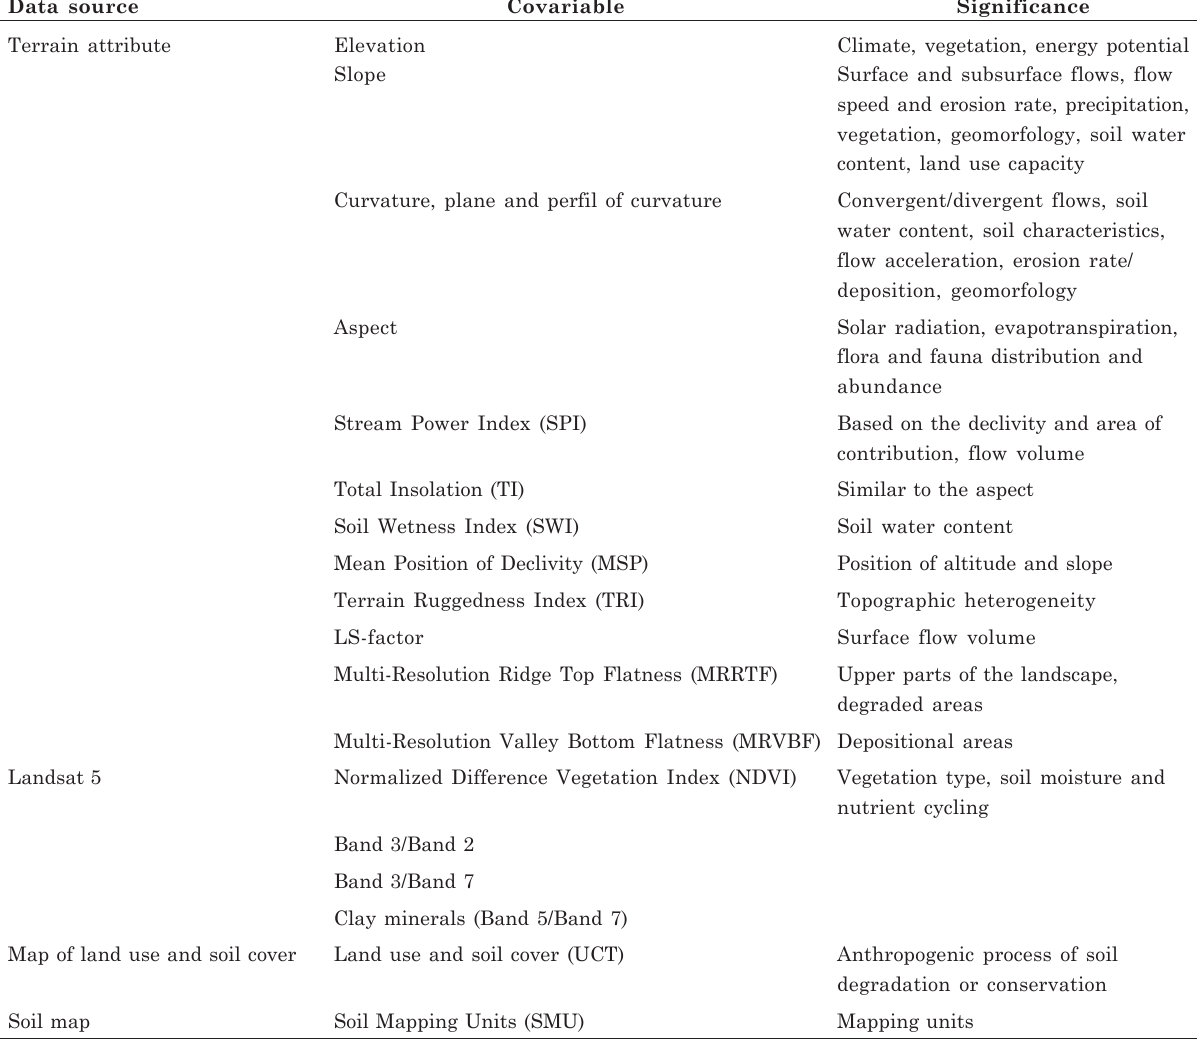
Table 2. Environmental covariates